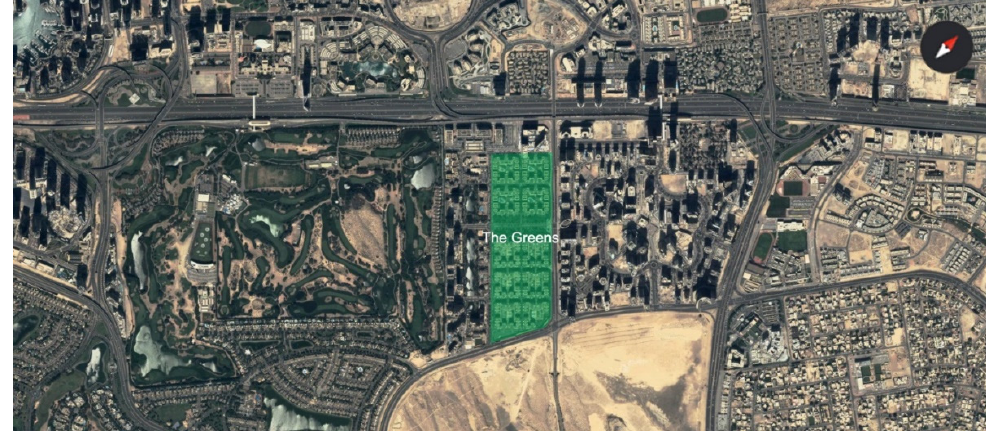
Figure 1. The Location of The Greens in Dubai, United Arab Emirates.